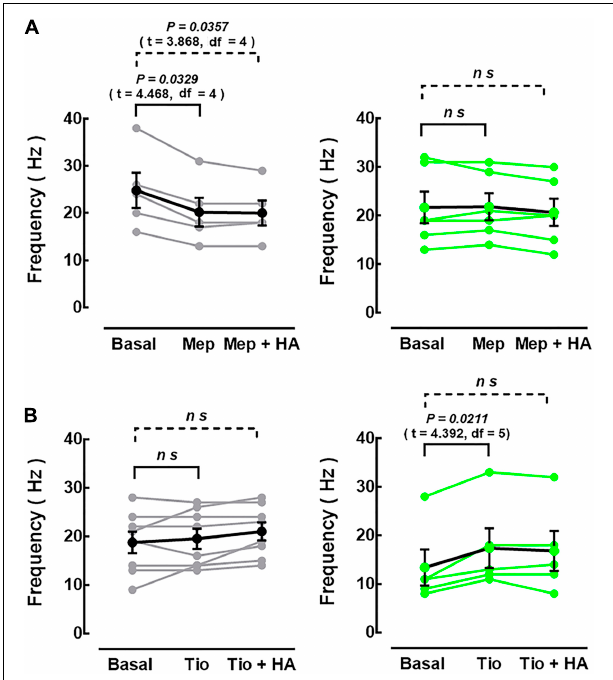
FIGURE 7 | Effect of antagonists/inverse agonists at histamine H 1 or H 2 receptors on action potential frequency. The firing frequency induced by the injection of depolarizing current (300 pA, 1 s) in neurons from the control [ (A,B) , left black and gray circles] and chlorpheniramine [ (A,B) , right green circles] groups was evaluated in basal conditions (no drugs), after the perfusion of the H 1 R antagonist/inverse agonist mepyramine (Mep, 1 µ M) or the H 2 R antagonist/inverse agonist tiotidine (Tio, 1 µ M), and in the presence of histamine (10 µ M) and mepyramine (Mep + HA) or tiotidine (Tio + HA). Values (control: black dots; chlorpheniramine: green dots) are means ± SEM from 5 to 8 neurons for each condition of 4 P21 animals from three different litters per group. Black or green lines connect values from the same neuron. The statistical analysis was performed with one-way ANOVA and Holm-Sidak’s multiple comparisons test. ns, non-significant